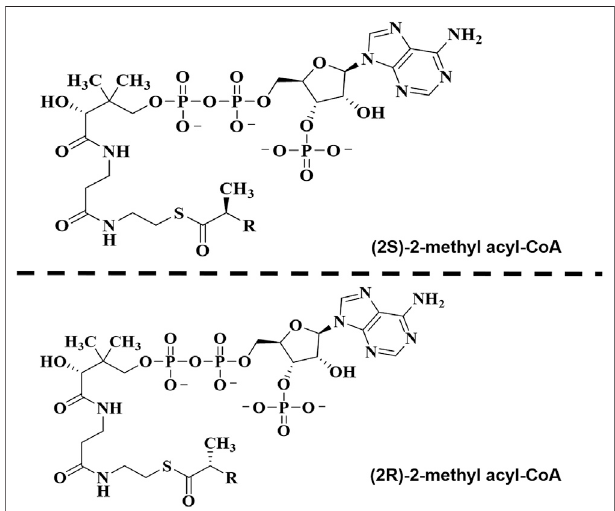
FIGURE 2 | Illustration for the oxidation step of (3R)- and (3S)-phytanic acid as resulting from normal diet and (25R)-trihydroxy co fl uorocarbonate (THCA) biosynthesized from liver-derived